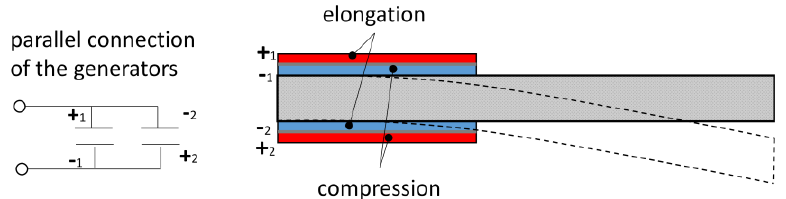
Figure 6. Parallel connection of two piezo films on the carrier substrate to avoid excessive voltage peaks.